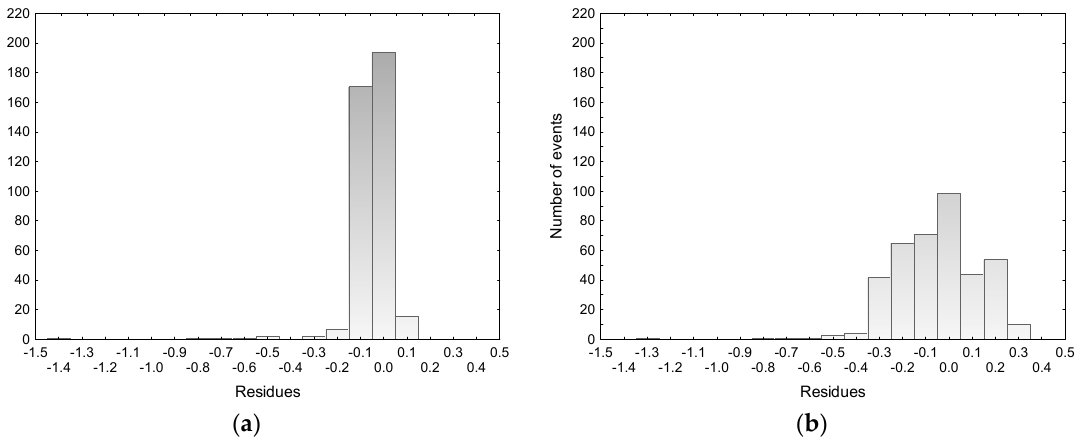
Figure 4. Residual histograms of predicted GWLs (m) with SVR time series in the N-8 well in the test subset for the best ( a ) and the worst ( b ) combination of predictors.